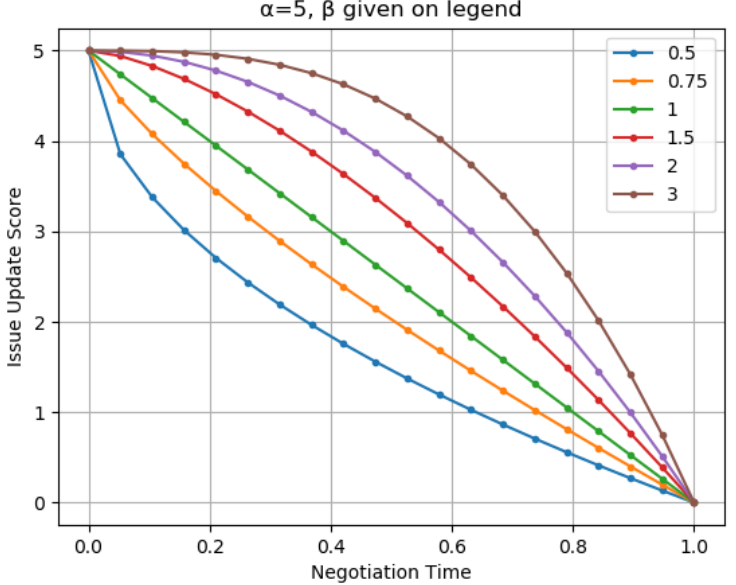
Figure 5. The issue weight update for various levels of β